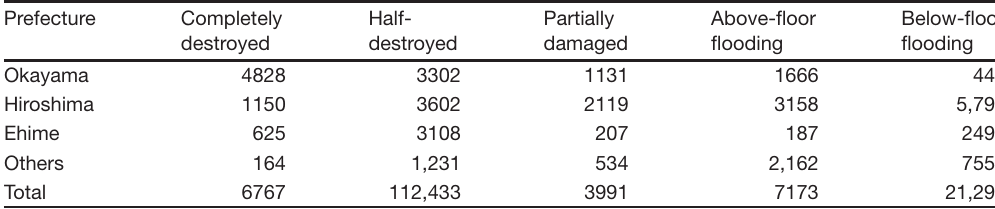
Table 2. Houses damaged (as of 9 January